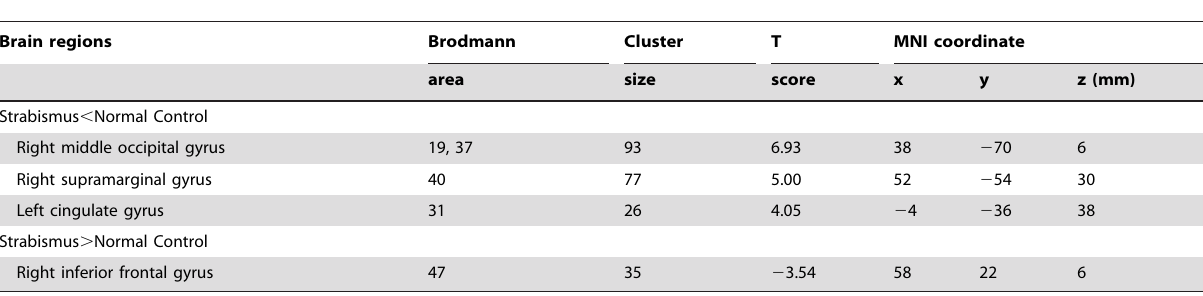
Table 3. Locations of white matter regions with FA changes in adult strabismus.